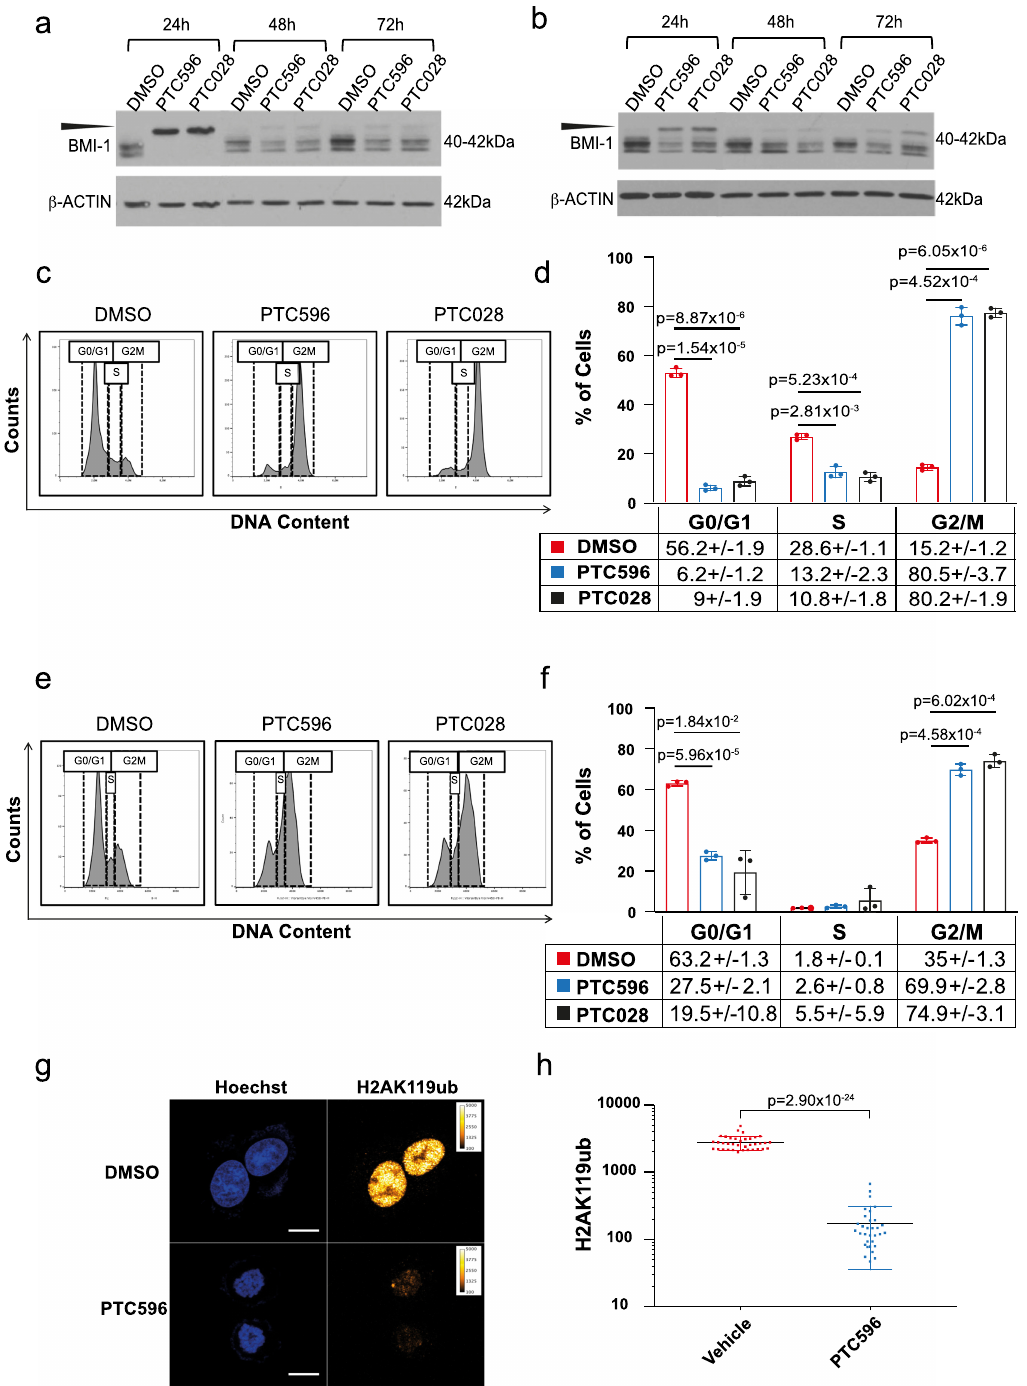
Fig. 6 PTC596 treatment of the KRAS mutant A549 and SKLU1 cell lines affects their cell cycle progression. Western blot analyses of human a A549 and b SKLU1 cell lines treated for 24, 48, and 72 hours with DMSO vehicle as control, and PTC596 or PTC028. Protein lysates were immunoblotted with an anti-BMI-1 antibody. Loading was assessed with an anti- β -actin antibody. The expected size is shown in kDa. The slower migrating hyperphosphorylated BMI-1 band is indicated by the arrowhead. c – f Cell cycle analysis of the A549 c – d and SKLU1 e – f cell lines after treatment for 24 hours with DMSO (red), PTC596 (blue), or PTC028 (black). The bar charts ( d and f ) represent the distribution of cells in G 0 -G 1 , S, and G 2 -M phases. P values are indicated. Error bars represent standard deviation (SD). Percentages of cells in each cell cycle phase are indicated. g Fluorescence nuclear imaging of DNA and H2AK119ub in A549 cell line by confocal microscopy. Upper panels show DMSO-treated cells; lower panels show cells treated with PTC596 for 24 hours. Left panels show DNA staining by Hoechst 33342 (blue acquisition chanel). Right panels show H2AK119ub staining by immuno fl uorescence (scale bar 10 μ m). h Dot plots of H2AK119ub average nuclear fl uorescence for DMSO − (red) and PTC596-treated (blue) A549 cells. Error bars represent SD of the average values. Data are expressed in fl uorescence counts which are proportional to H2AK119ub concentration. P value is